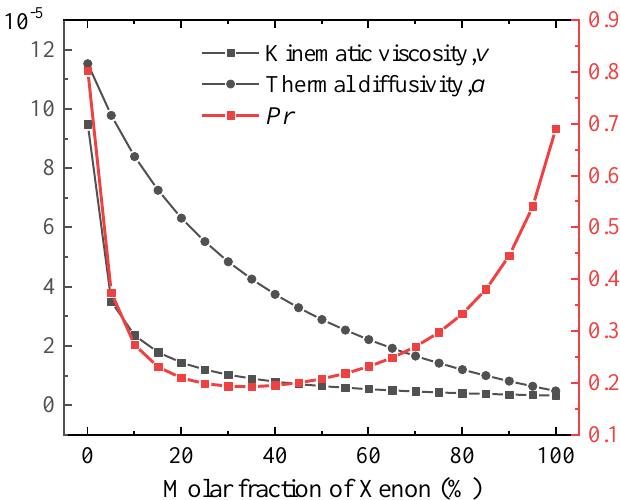
Figure 8. The properties of He–Xe vs. the molar fraction of xenon ( P = 0.6 Mpa, T = 640 K). The physical properties make the heat transfer process of He–Xe in turbulence flow significantly different from that of liquid metal and air [39]. Figure 9 shows the radial velocity and temperature distribution of He–Xe, the composition of which is 29% Xe and 71% He, near the wall in a channel under the condition that the heat flux is 1 kW/m 2 and the inlet Re is 2500.